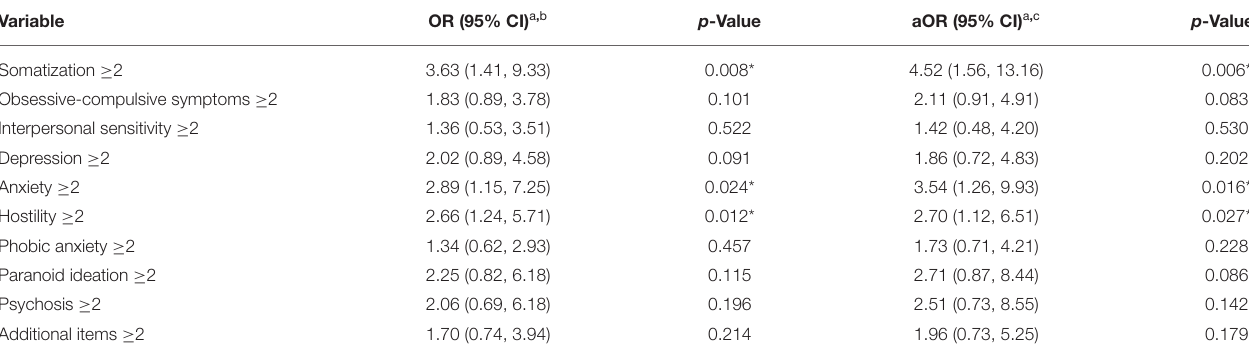
TABLE 4 | Comparison of psychological symptoms among pregnant HCWs and pregnant non-HCWs.